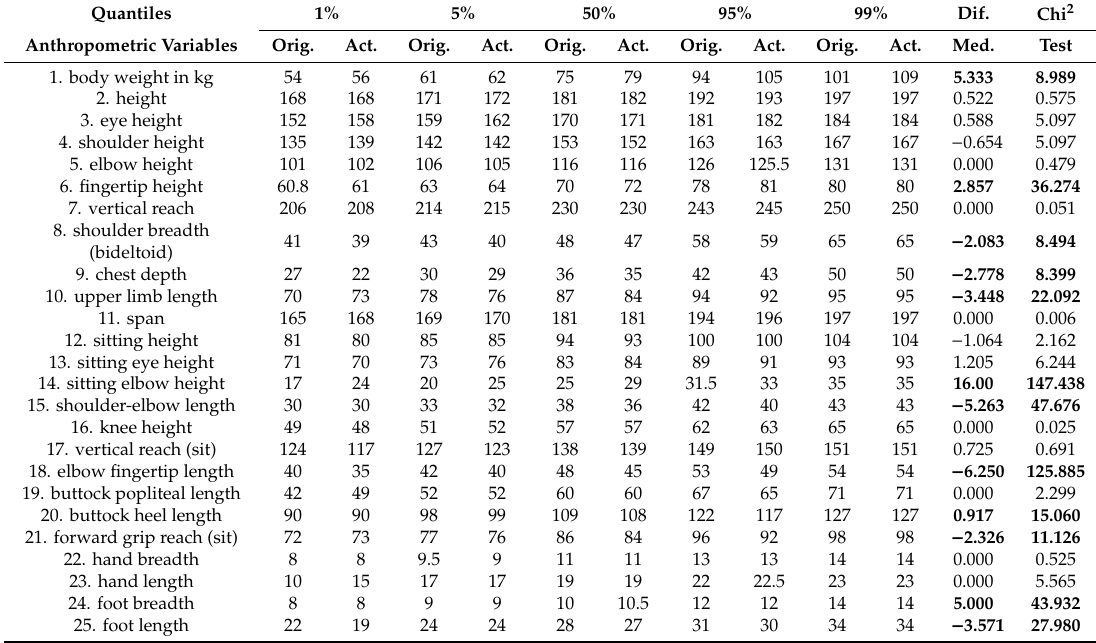
Table 7. Comparison of the original (the year 2004) and actual (the year 2018) quantiles of selected anthropometric variables of the male population in the Slovak